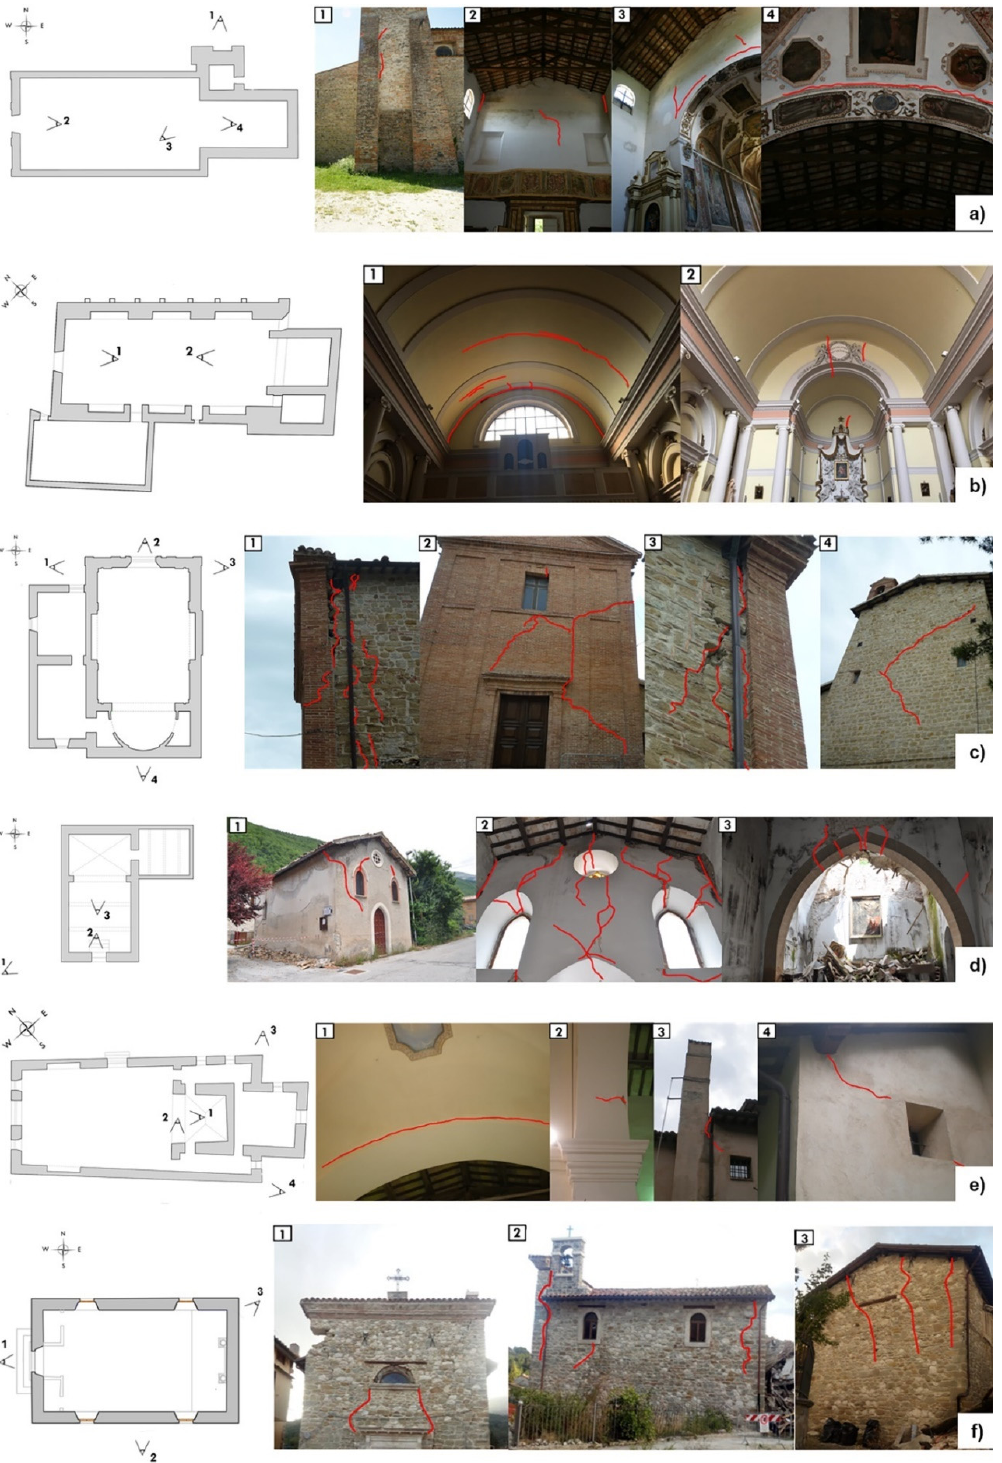
Figure 2. Main damages in: San Francesco Church in Montefortino ( a ), San Francesco Church in Sarnano ( b ), Sant’Anna Church in Camerino ( c ), Sant’Antonio Church in Ussita ( d ), Madonna of Valcora Sanctuary in Fiuminata ( e ), Santissimo Crocifisso in Arquata del Tronto ( f ).